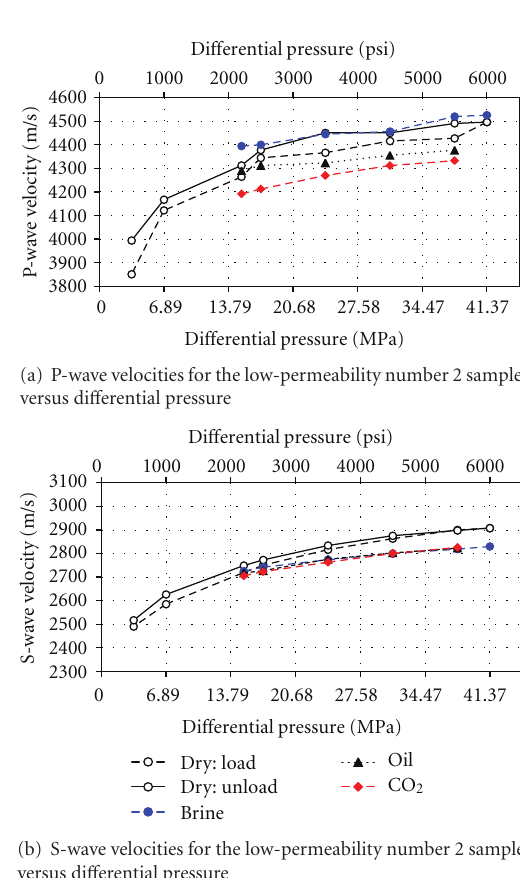
Figure 10: P- and S-wave velocities for the low-permeability number 2 sample versus di ff erential pressure for dry rock, brine saturated, and when flushed with live oil and CO 2 .